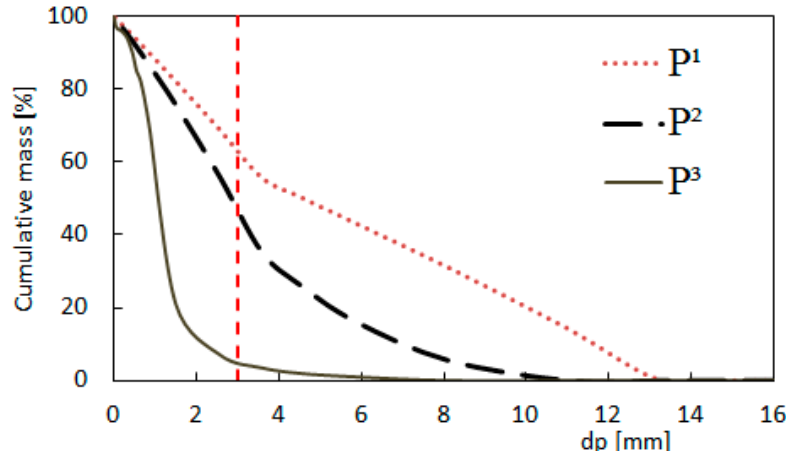
Figure 10. Size distribution analysis of the cumulative altered granite particles, capable of passing through the gap using the breakage distribution function. P 1 , P 2 and P 3 represent the three stages necessary to obtain less than 5% of particles above the gap size. dp is the arithmetic average of the mesh size intervals.